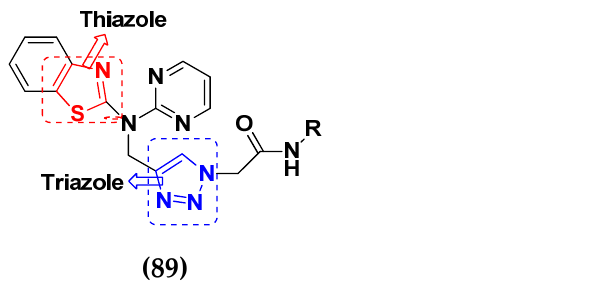
Figure 86. Structure of triazole-thiazole derivative ( 89 ). Table 75. In vitro cytotoxic activities of triazole-thiazole hybrid compounds 89 ( a – c ). Compound